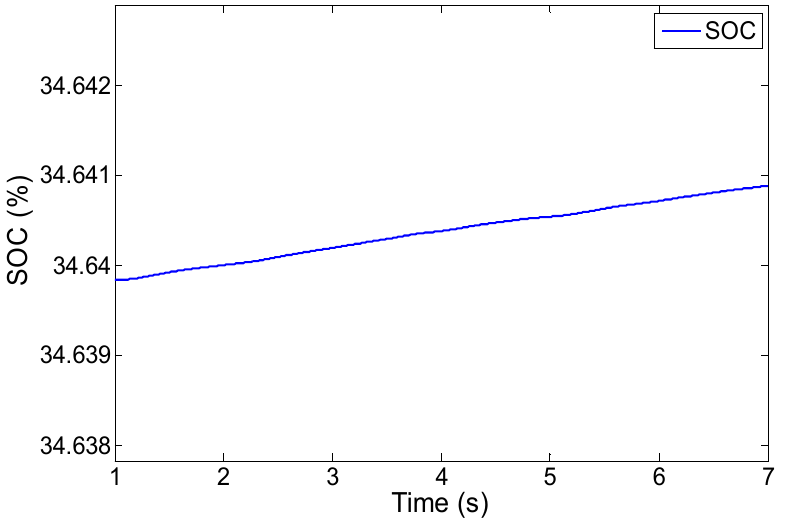
Figure 27. SOC level in the second case, when ∆ P was not limited.